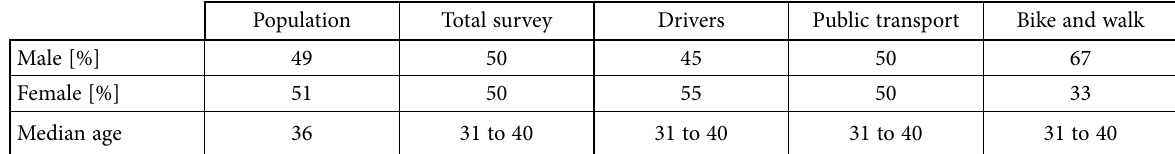
Table 4. Comparison of respondent characteristics with the population in Melbourne Population Total survey